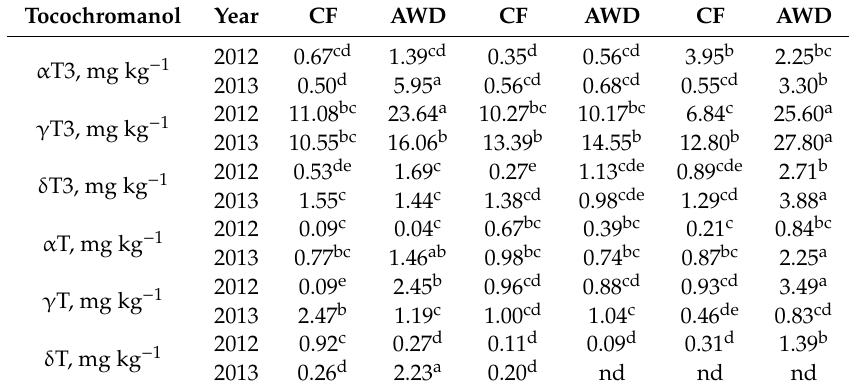
Table 4. Concentrations of the single tocochromanols in brown grains of three rice cultivars grown under continuous flooding (CF) or alternate wetting and drying